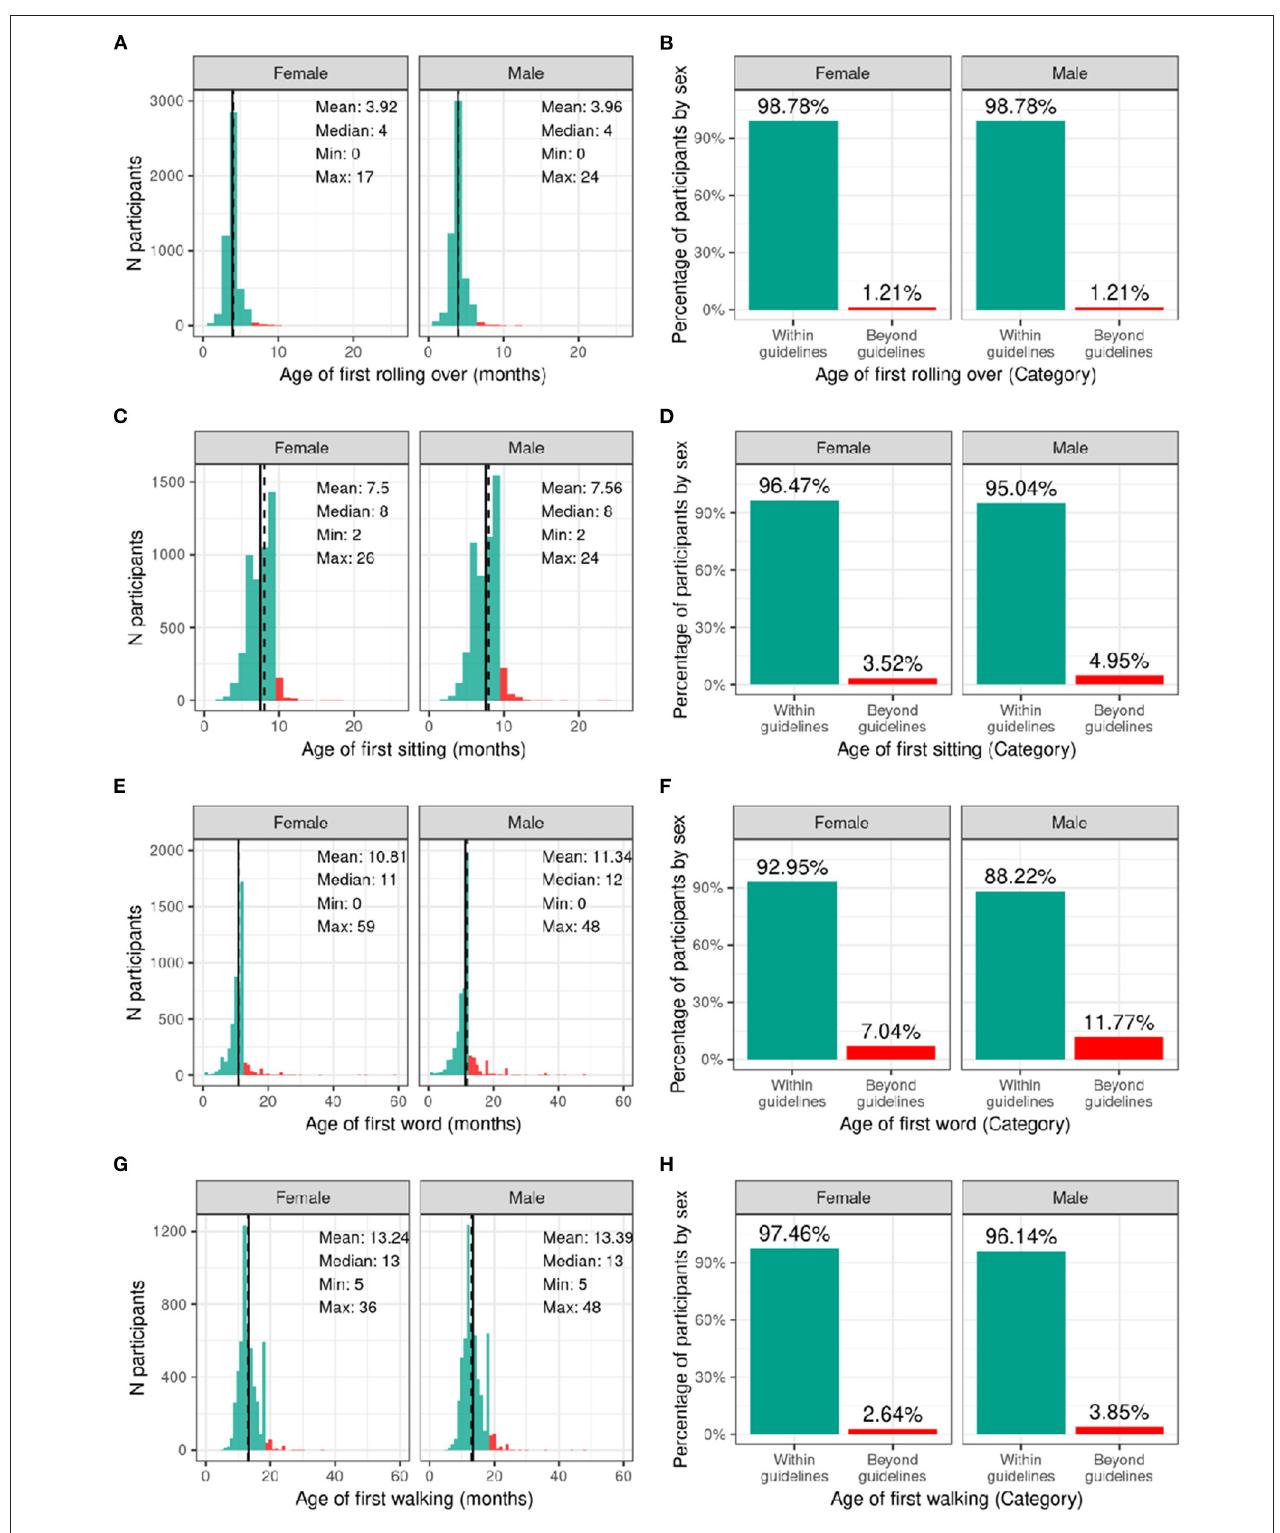
FIGURE 3 | Distribution of age at reaching developmental milestones in the ABCD sample. Distribution of ages in months when each participant reached each developmental milestone stratified by sex assigned at birth, and percentage of those within the recommended developmental guidelines (green) and beyond the guidelines (red) for when each participant first (A,B) rolled over (C,D) sat on their own (E,F) said their first word (G,H) started walking.